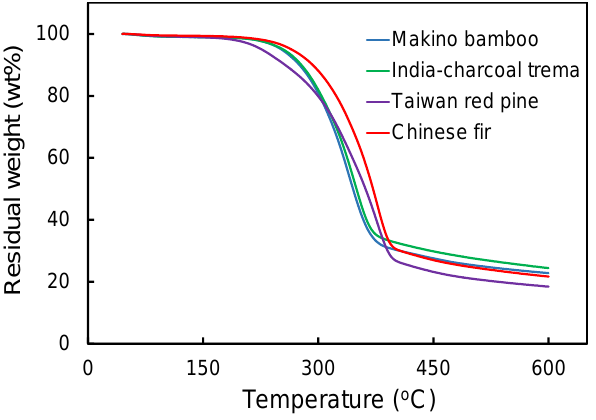
Figure 4. Thermogravimetric analysis of various lignocellulosic materials at a heating rate of 20 °C/min. To analyze the thermal decomposition mechanisms in depth, the Friedman, F-W-O and modified C-R methods were used. As an example, the Friedman, F-W-O and modified C-R plots for Chinese